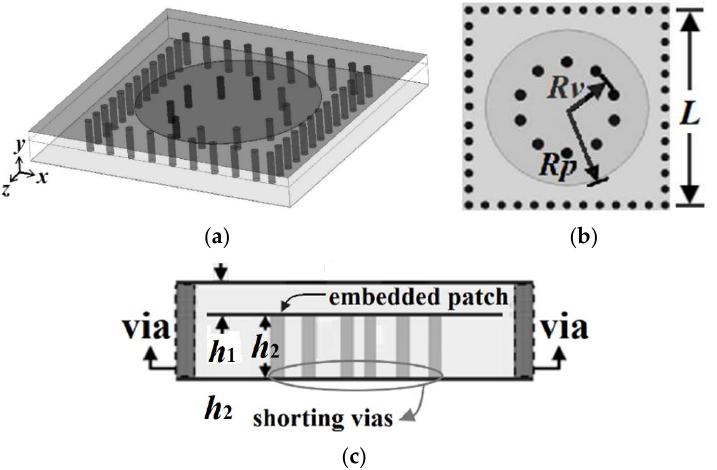
Figure 1. The full-mode SICR: ( a ) the 3-D view, ( b ) top transparent view, and ( c ) side view.